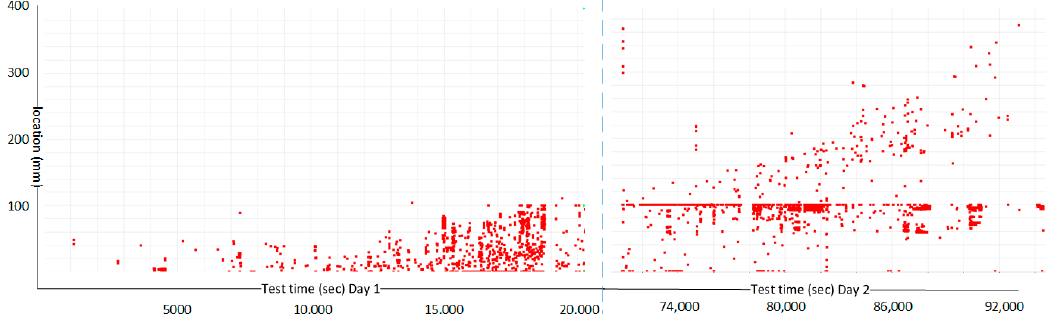
Figure 8. Acoustic emission localization during fatigue loading of the plydrop specimen (testing over two days).